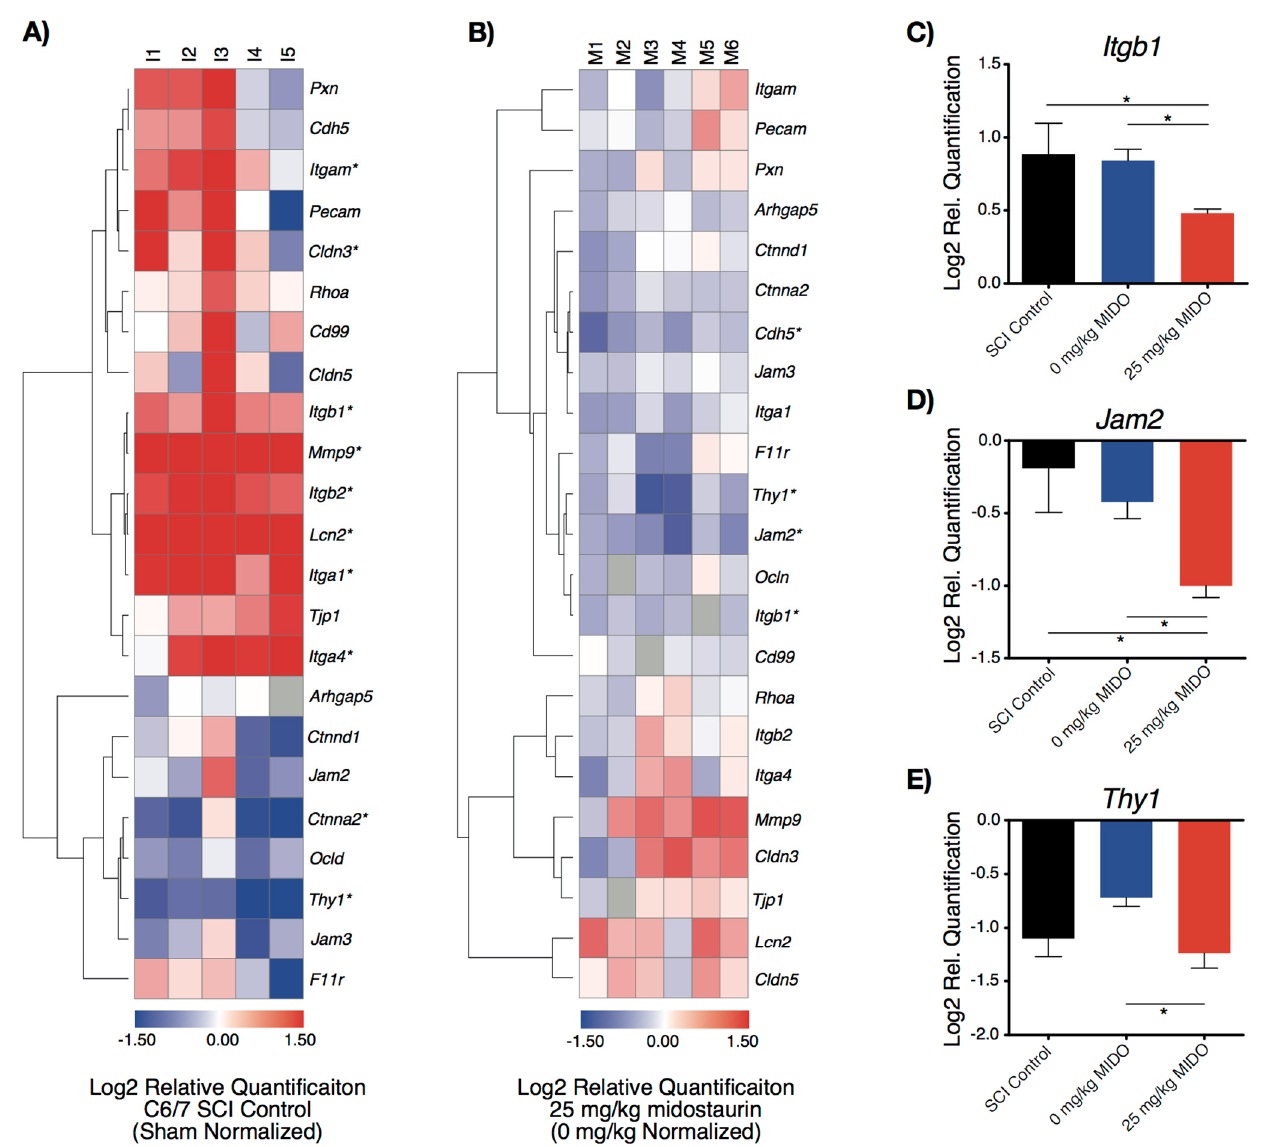
Figure 3. Expression of trans-endothelial migratory genes (KEGG Pathway: rno04670) at 24 h post operation in the laminectomized sham ( n = 6), C6/7 SCI control ( n = 5), 0 mg/kg midostaurin ( n = 6), and 25 mg/kg midostaurin ( n = 6) cohorts. ( A , B ) Hierarchical clustering was based on cosine similarity. Statistically significant changes are illustrated with an asterisk (*), as determined by a t-test using FDR according to the two-stage linear set-up procedure of Benjamini, Krieger, and Yekutieli to correct for multiple comparisons. ( A ) Heat map illustrates log 2 fold change in the C6/7 SCI control cohort relative to uninjured shams. ( B ) Heat map illustrates log 2 fold change in the 25 mg/kg midostaurin-treated SCI cohort compared to the 0 mg/kg midostaurin SCI group. ( C – E ) Statistically significant expressions in 25 mg/kg midostaurin-treated SCI animals compared to 0 mg/kg midostaurin-treated SCI animals for genes involved in the adhesion of immune cells to the spinal endothelial cells (determined by one-way ANOVA using Holm–Sidak for multiple comparisons; demonstrated in log 2 sham-normalized relative quantification ± SEM; *: p < 0.05).